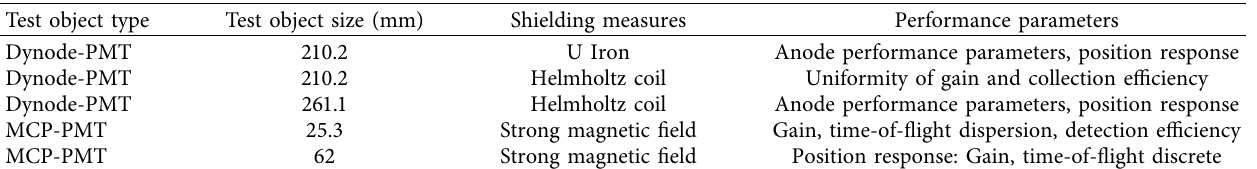
Table 3: Comparison of the test parameters of the magnetic field influence of photoelectric devices.